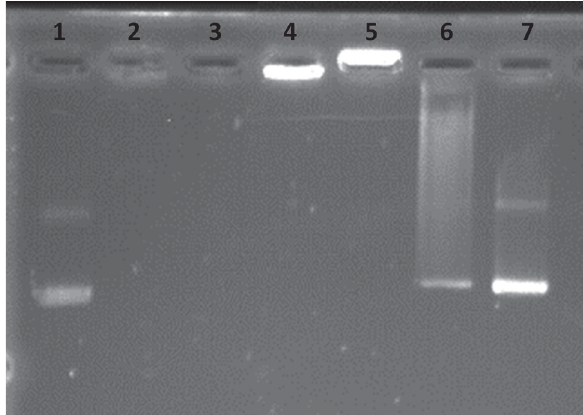
and SLN formulations EQ1 CTAB